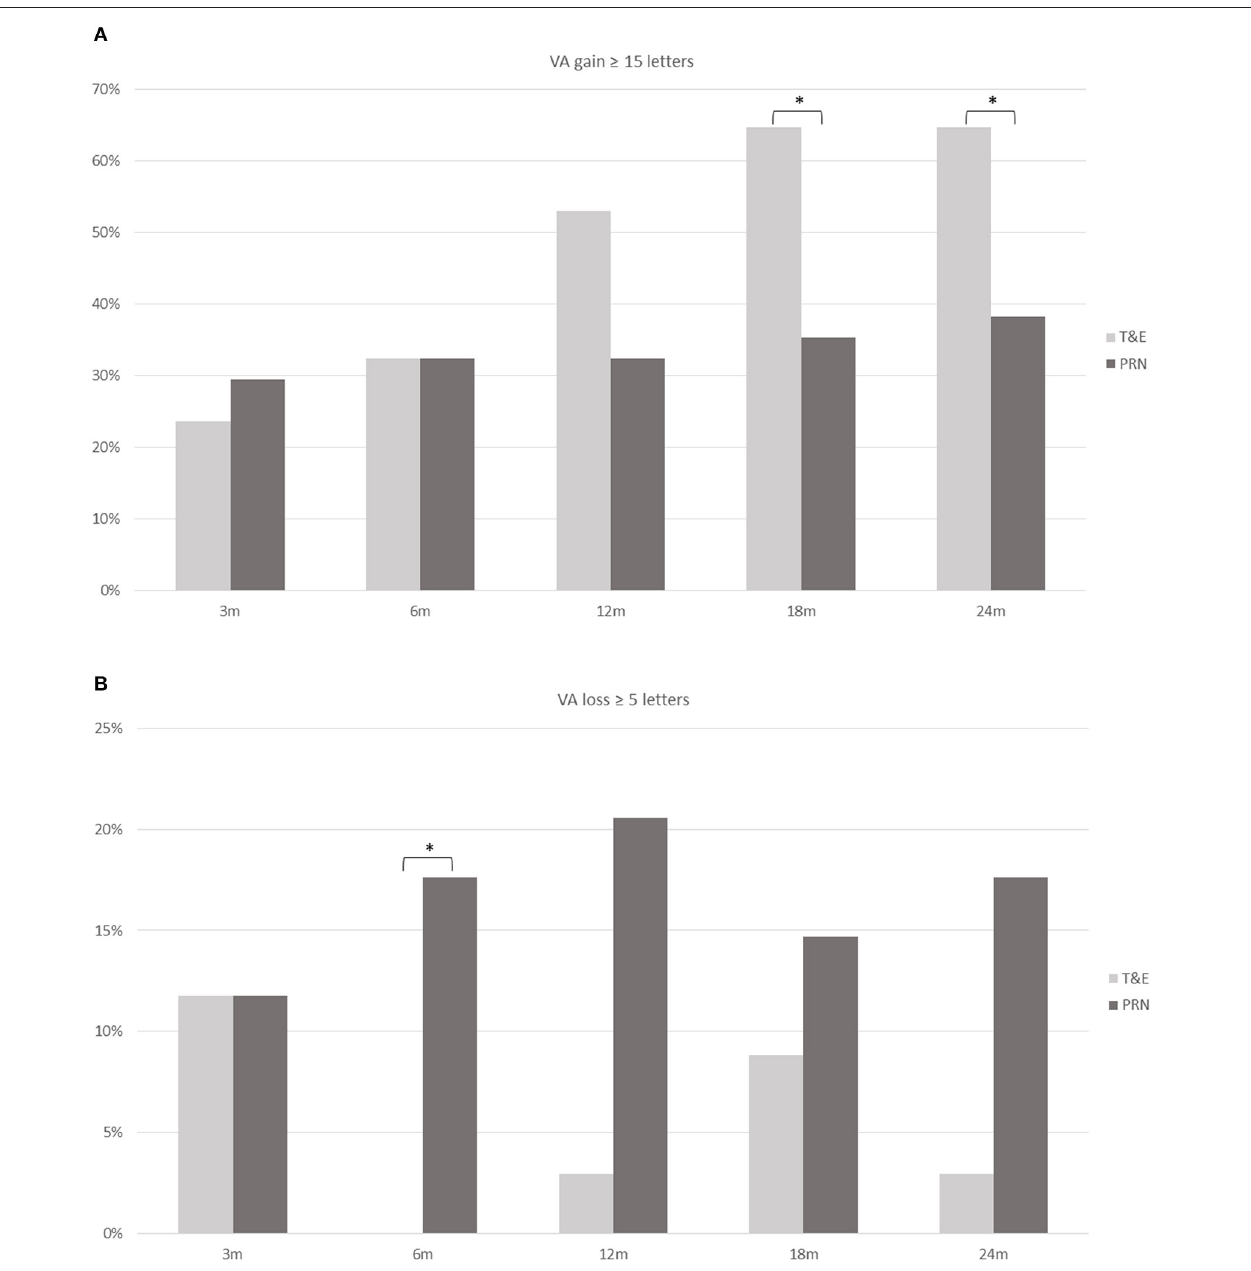
FIGURE 2 | The proportion of patients who achieved a gain of ≥ 15 ETDRS letters (A) and those who had a loss of ≥ 5 letters (B) at different time points in the T&E and PRN groups. A significant difference (asterisk) is found at 18 and 24 months in those who gained ≥ 15 letters and at 6 months in those who had a loss of ≥ 5 letters. ETDRS, Early Treatment Diabetic Retinopathy Study; T&E, treat-and-extend; PRN, pro re nata; VA, visual acuity. * p < 0.05.